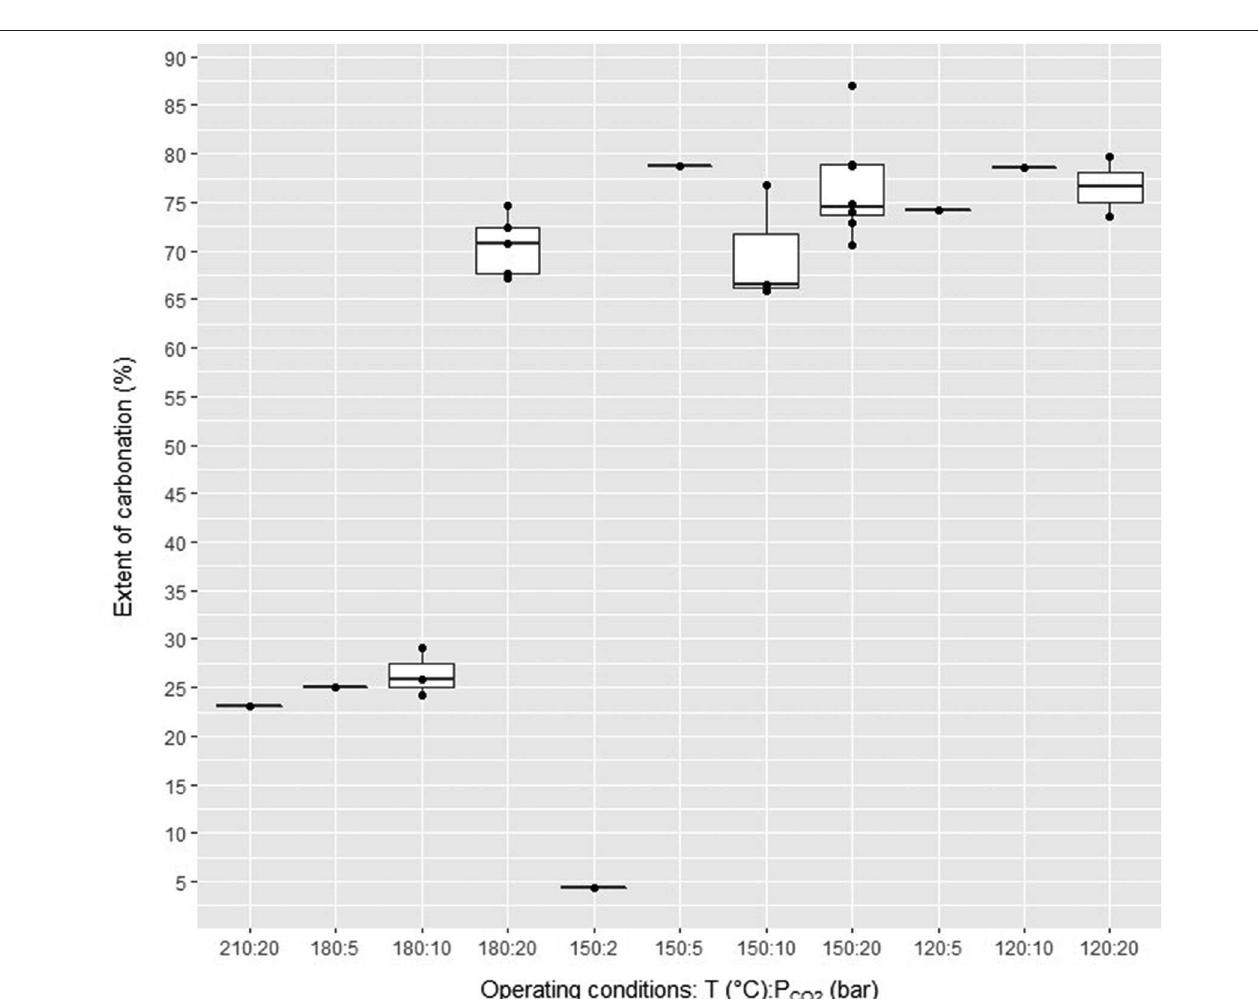
FIGURE 8 | Measured extent of carbonation (27 observations in total) of the attrition-leaching carbonation process with ferronickel slag (reaction time = 24h).